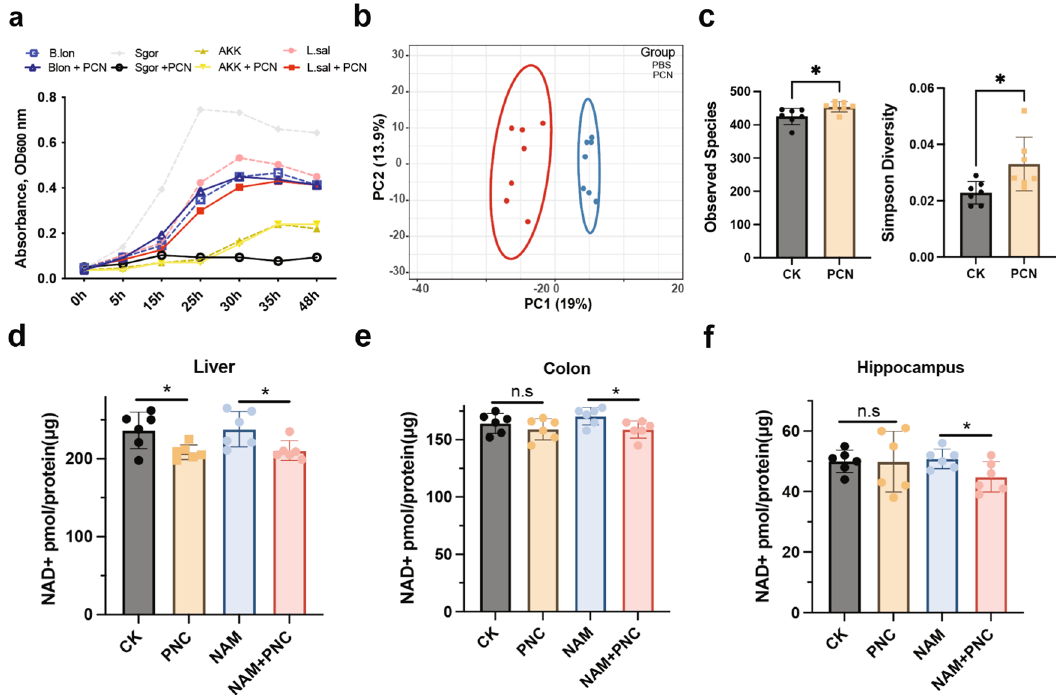
Fig. 2 PncA inhibitor disrupts intestinal microbiome homeostasis and reduces host NAD + level. a Effects of PCN on the growth of bacteria with different NAD + synthesis pathways. b PCA diagram of the intestinal fl ora in mice treated with PCN ( n = 7). c Intestinal microbial species and diversity after PCN treatment in mice ( n = 7, * p < 0.05). d – f NAD + level in the liver, intestine, and hippocampus of mice ( n = 6, * p < 0.05, n.s = no signi fi